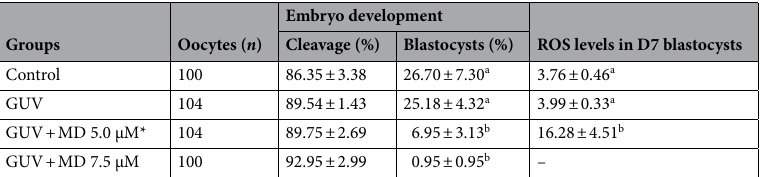
Table 1. Development and intracellular concentrations of reactive oxygen species (ROS) in bovine embryos cultured in vitro in the presence of giant unilamellar vesicles (GUVs) and subjected to menadione (MD)- induced oxidative stress. Data are expressed as the mean ± standard error of four independent replicates. *Embryos were cultured for 7 days (D7), and menadione (5.0 μM or 7.5 μM) was included in the medium only on the sixth day of culture (from D6 to D7). ROS concentrations are expressed as arbitrary units of fluorescence (AUF). ab Different letters in each column indicate significant differences ( P < 0.05).